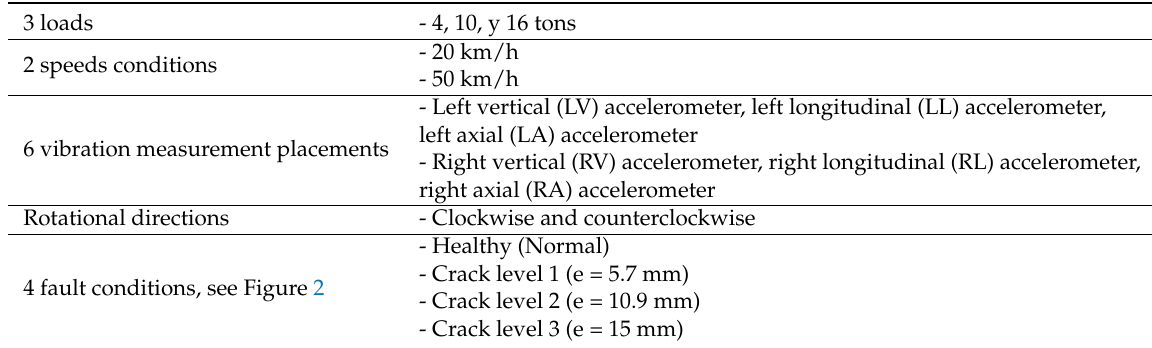
Table 2. Experimental